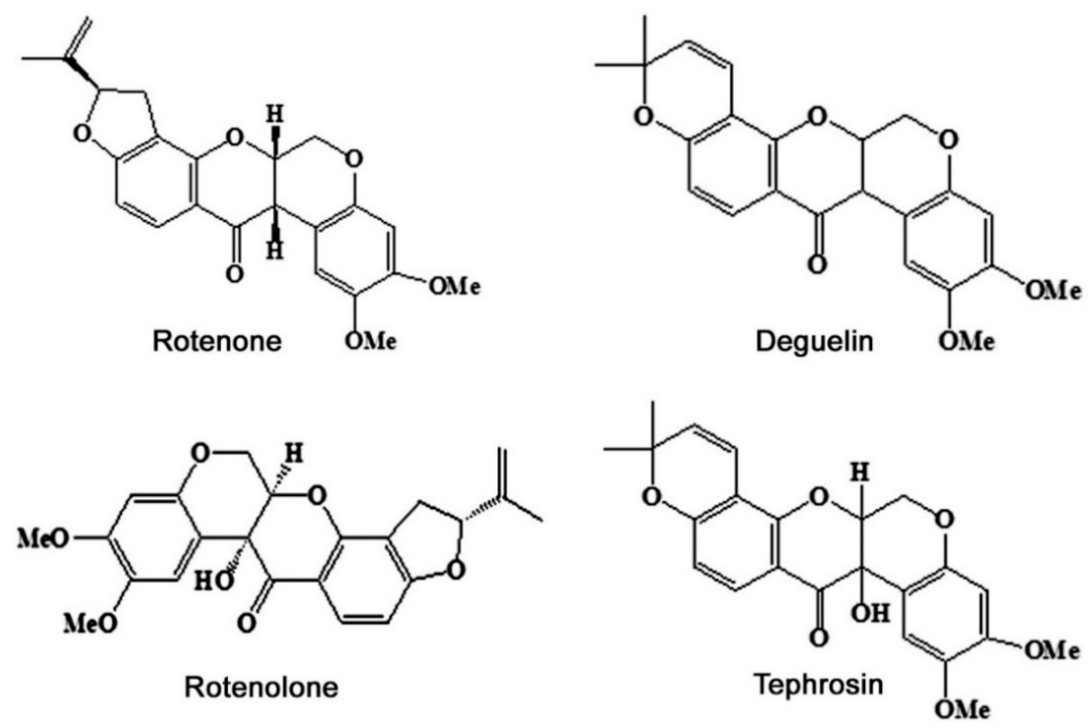
Figure 1. Major chemical constituents in Tephrosia vogelii plants .